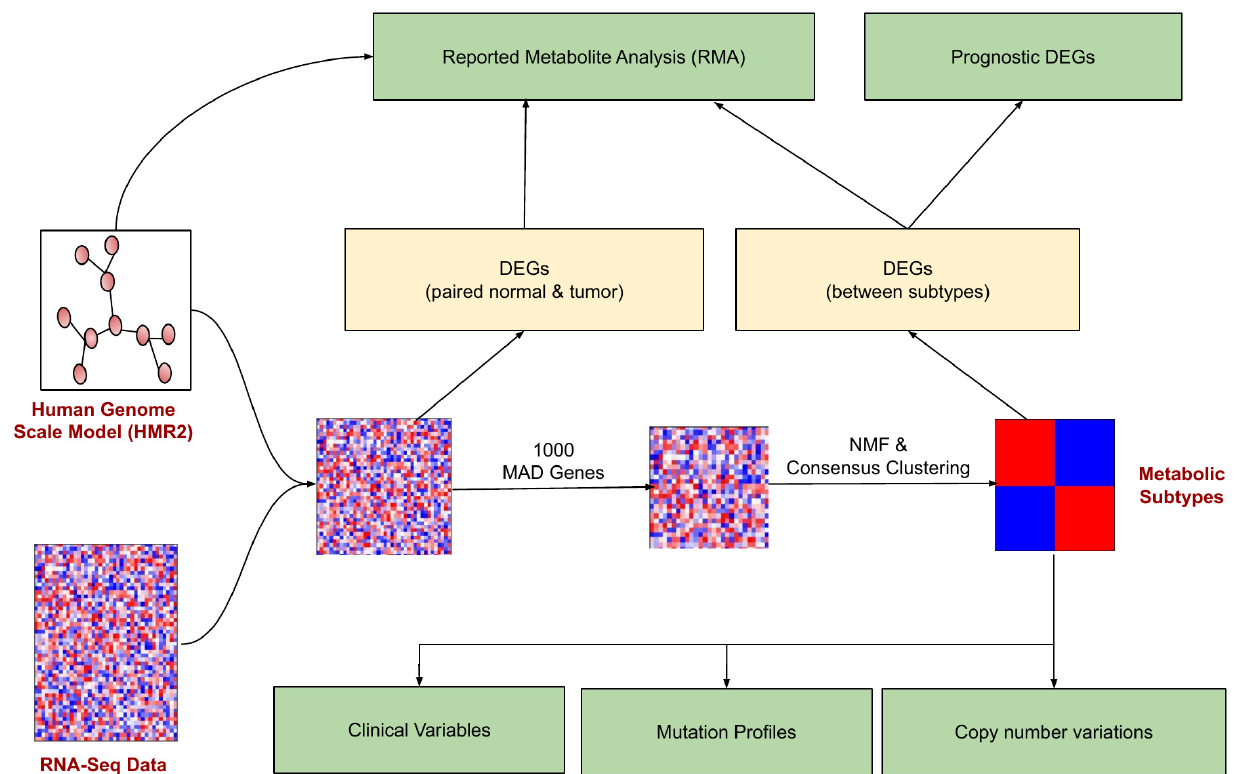
Figure 1. The workflow for metabolic EC subtype identification and characterization. The rectangular boxes (green) represent the study’s main outcomes: understanding the differences between EC metabolic subtypes (at clinical, mutation profile, and copy number variations) and identifying the reporter metabolites and prognostic DEGs.